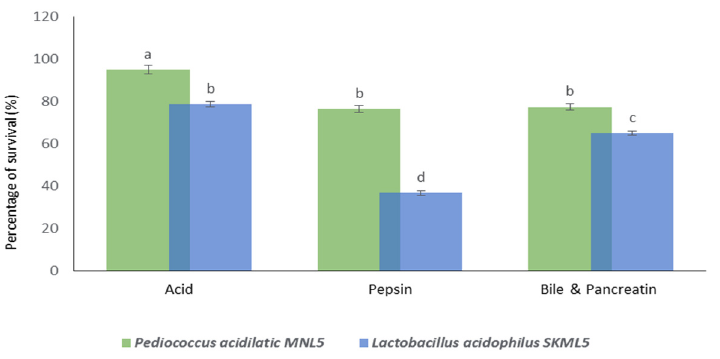
Figure 3. Stability of Lactic acid bacteria towards tolerance of acid, pepsin and Bile & Pancreatin. Values are expressed as the mean ± standard deviation ( n = 3). Different superscripts ( a, b, c, d ) represent significantly different values ( p < 0.05).